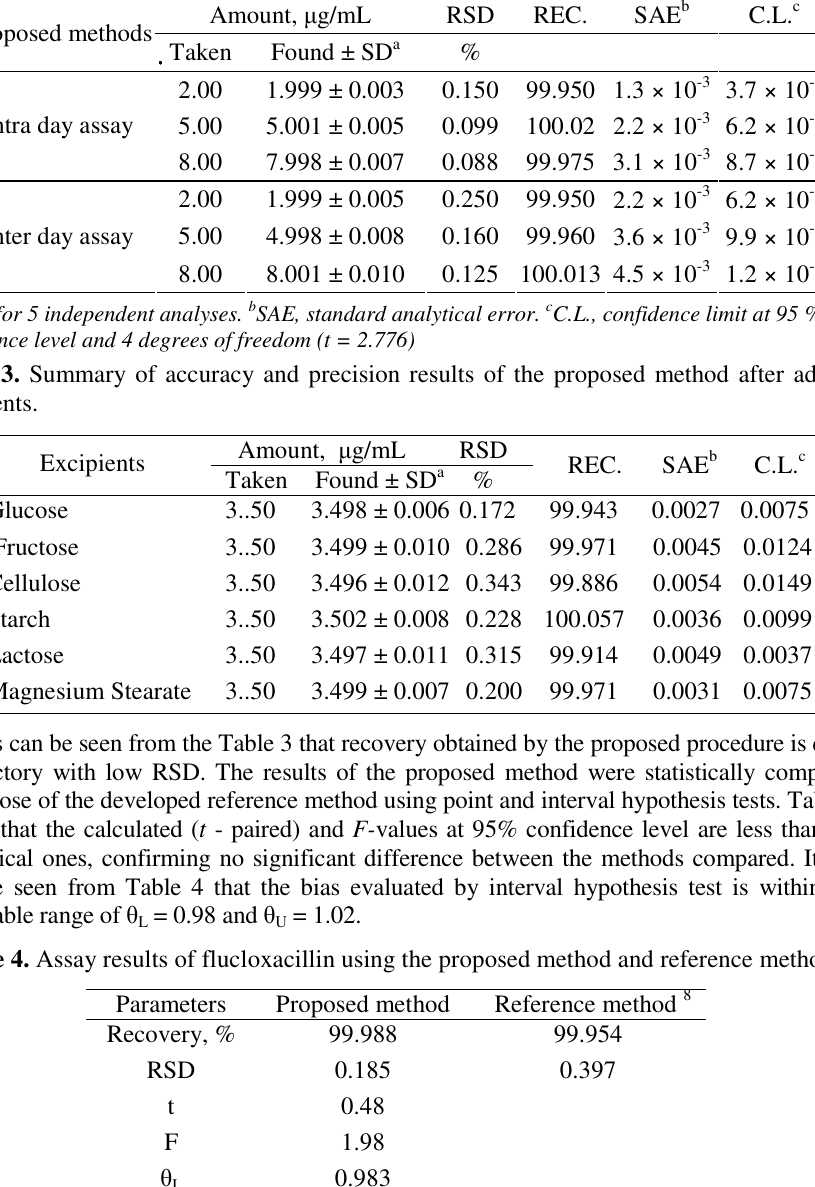
Table 2. Summary of accuracy and precision results of the proposed method in pure form.